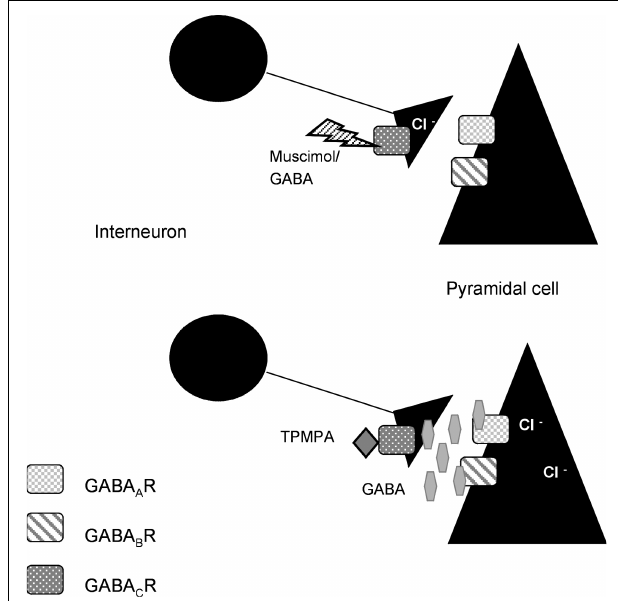
FIGURE 6 | Model for our hypothesis: GABA presynaptic side. Based on our results with GABA we assume that the receptors are located on the presynaptic side and act as autoinhibitors on the interneurons in the